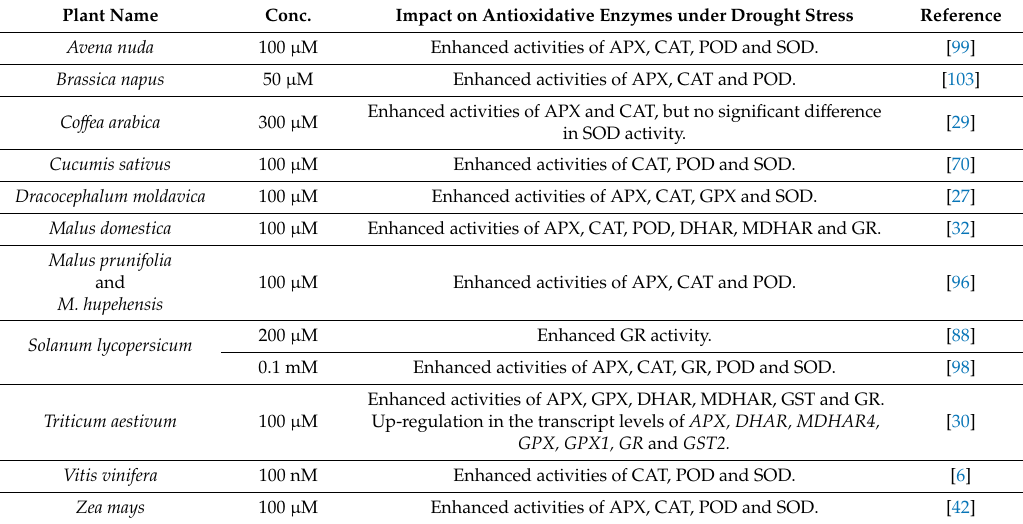
Table 3 summarizes the e ff ects of exogenous applied melatonin on the enzymatic antioxidants in plants growing under water deficit conditions. in plants growing under water deficit conditions. Table 3. Summary table explaining the e ff ect of exogenous applied melatonin on various anti-oxidative Table 3. Summary table explaining the effect of exogenous applied melatonin on various anti- enzymes under drought oxidative enzymes under drought stress.